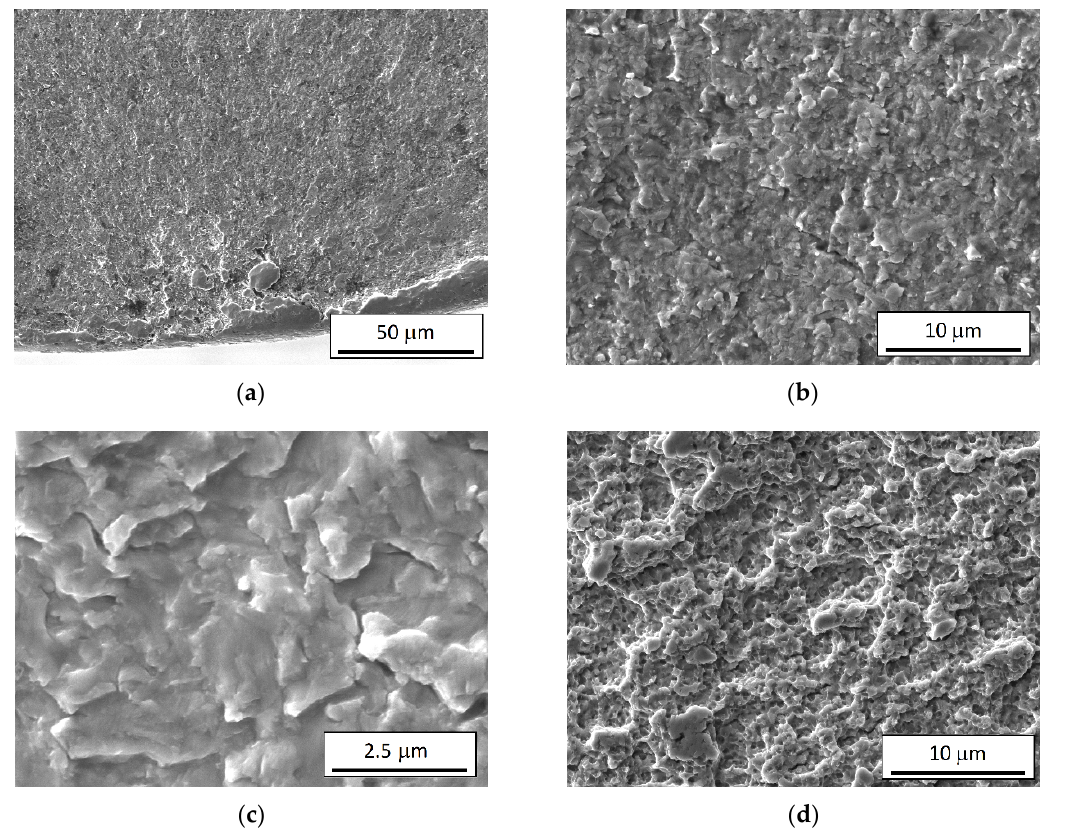
Figure 20. Fractographic analysis of the titanium Grade 4 specimen processed by one Conform SPD